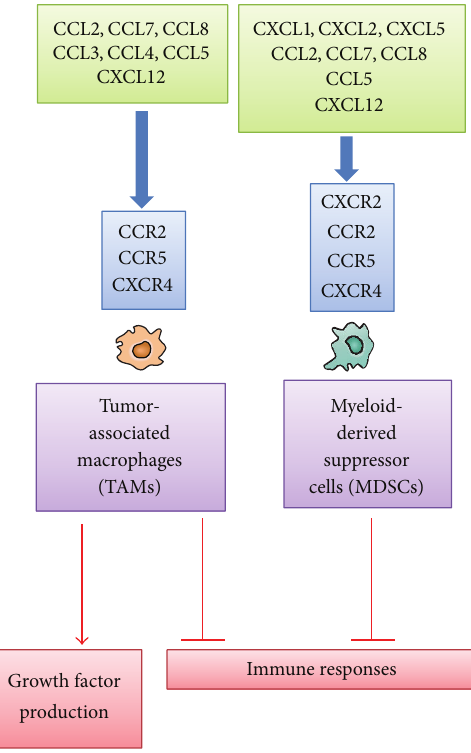
Figure 1: Chemokines acting on TAMs and